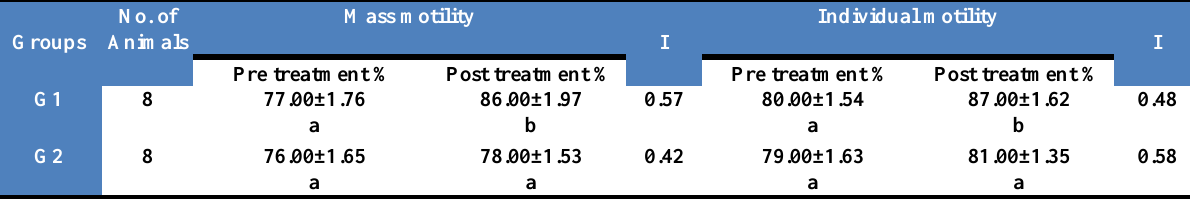
Individual motility I